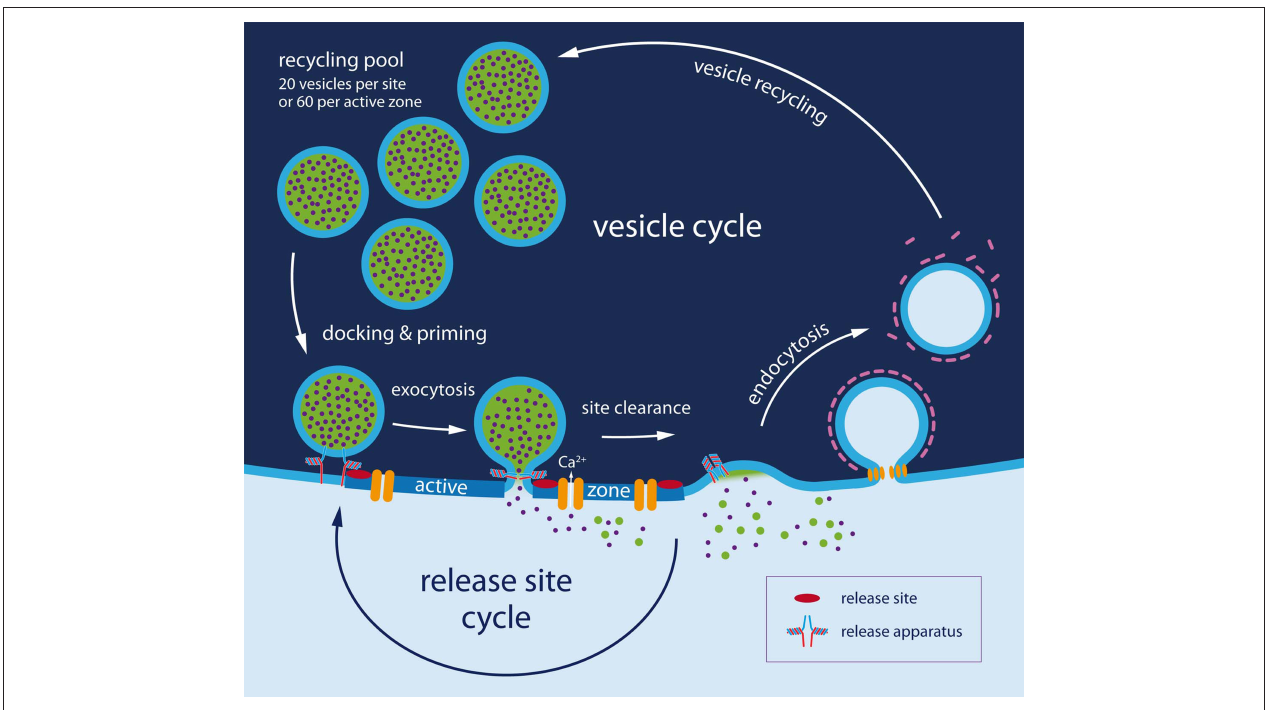
(3) Vesicle docking and priming. It is proposed (Neher and Sakaba, 2008; Hosoi et al., 2009) that vesicle docking and priming actually occurs very rapidly (within 100–200 ms) once a release site has been cleared and that site clearing is slow (200 ms to 10 s), being modulated by (Ca 2 + ) and other signaling